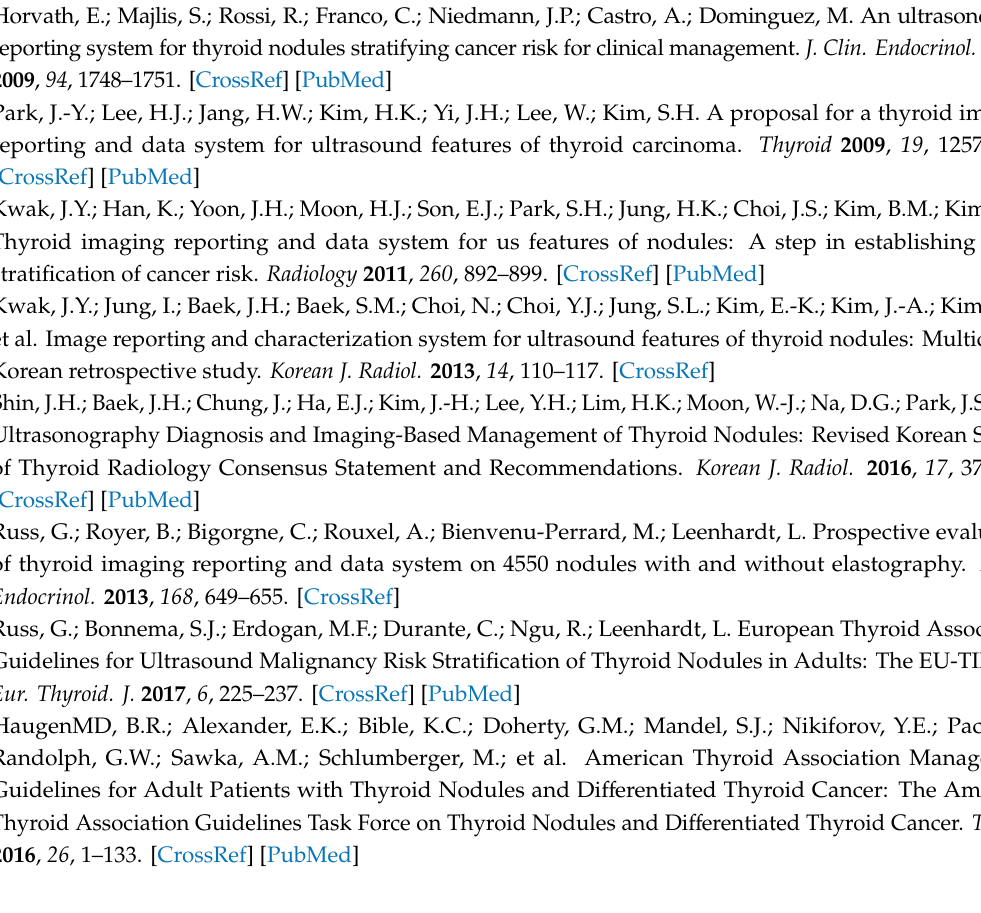
Figure S1: Selection of nodules for the study title, Table S1: Comparison of the incidence of US malignancy features and other sonographic features in the nodules with unequivocal (UC) and equivocal (EC) FNA results in relation to the histopathological outcome: benign lesion vs thyroid malignancy, Table S2: Data on the diagnostic e ffi cacy of analyzed TIRADSs in the examined groups of nodules—data for the thresholds set one category below the category that gave the highest ACC